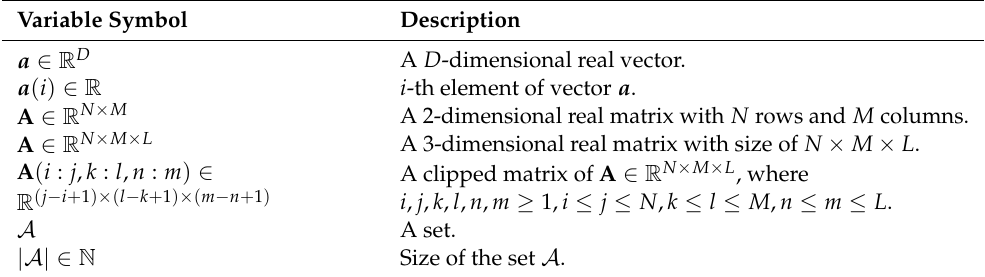
Table 1. Convention of variable representation. Variable Symbol